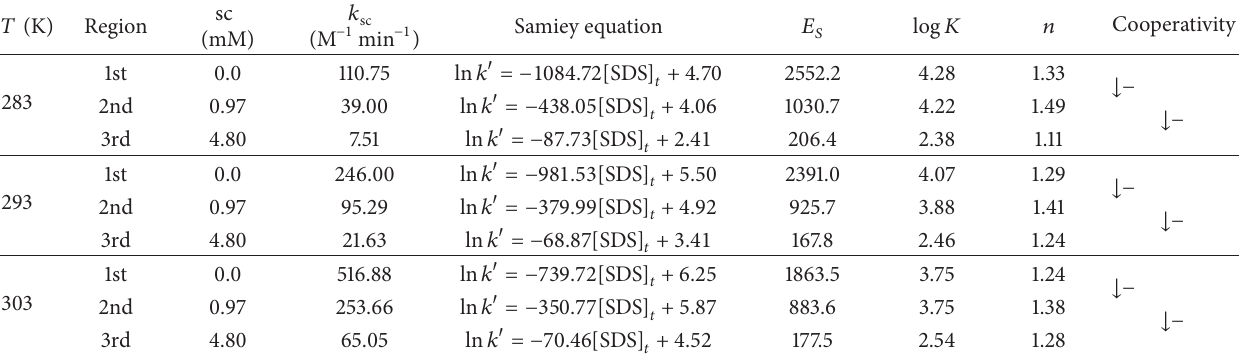
Table 1: Parameters obtained from stoichiometric model for interaction of ME 2+ with SDS at 283–303 K